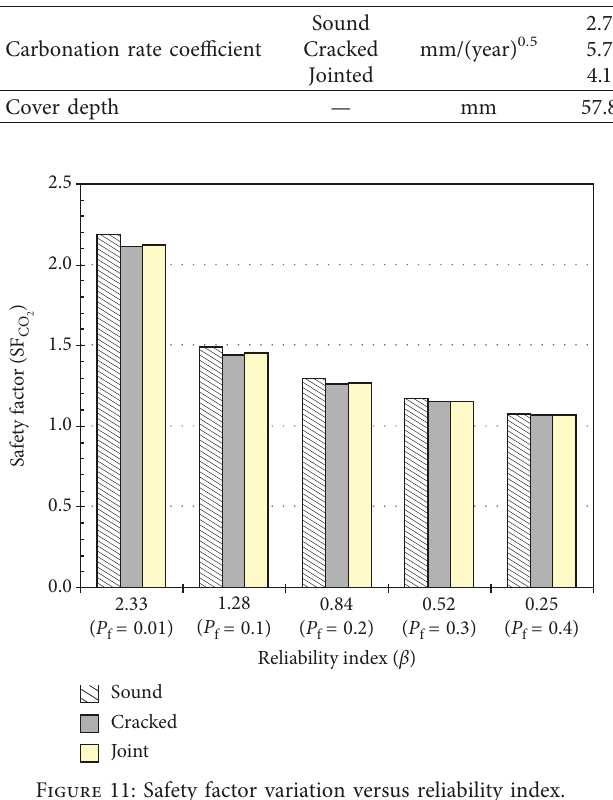
Figure 11: Safety factor variation versus reliability index.